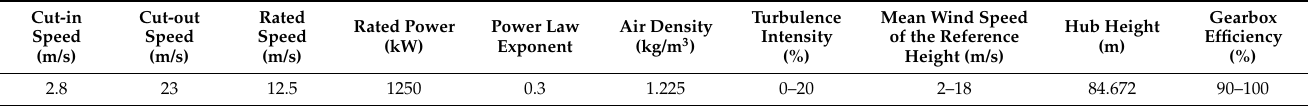
Table 2. The operating parameters used in the simulation process.